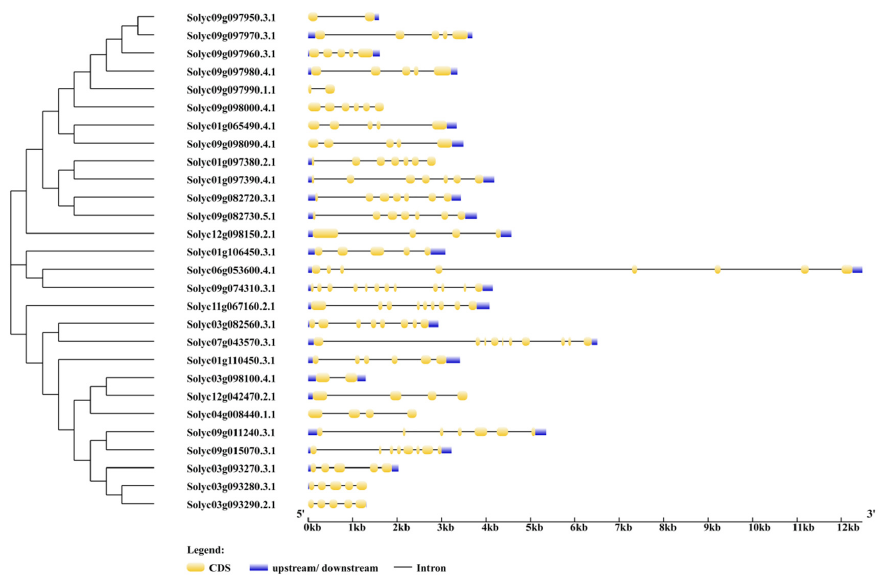
Figure 2. Phylogenic relationship of CDS and gene structures of AKR genes in Solanum lycopersicum . Phylogenic tree of SlAKR CDS was built by the neighbor-joining method, and the gene structures were analyzed by GSDS2.0 according to both genome and CDS sequences.